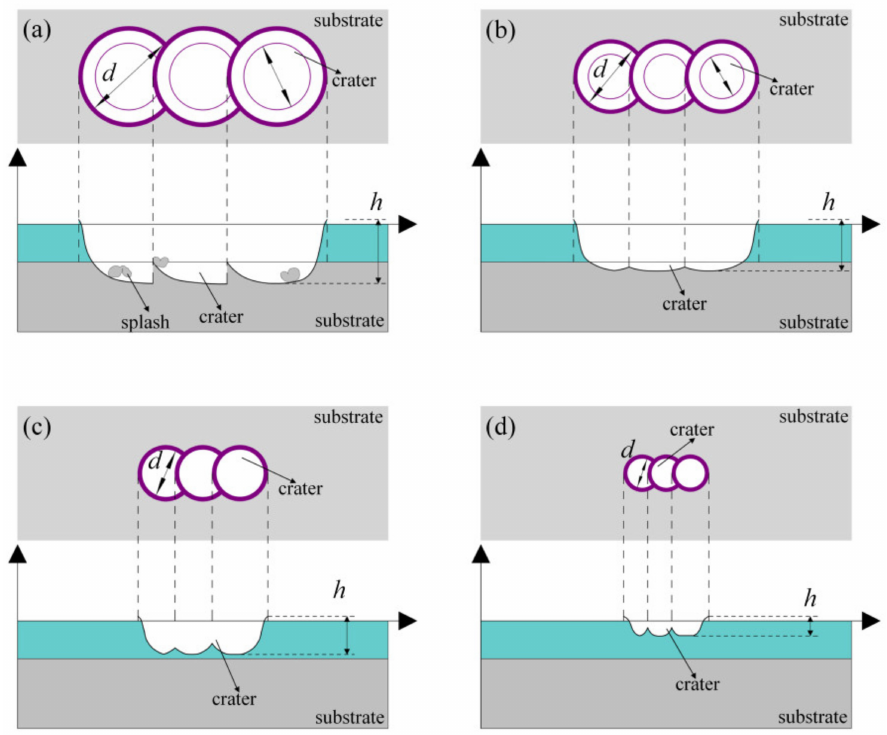
Figure 17. Variation of sample surface roughness with laser pulse frequency. ( a ) Stage 1; ( b ) Stage 2; ( c ) Stage 3; ( d ) Stage